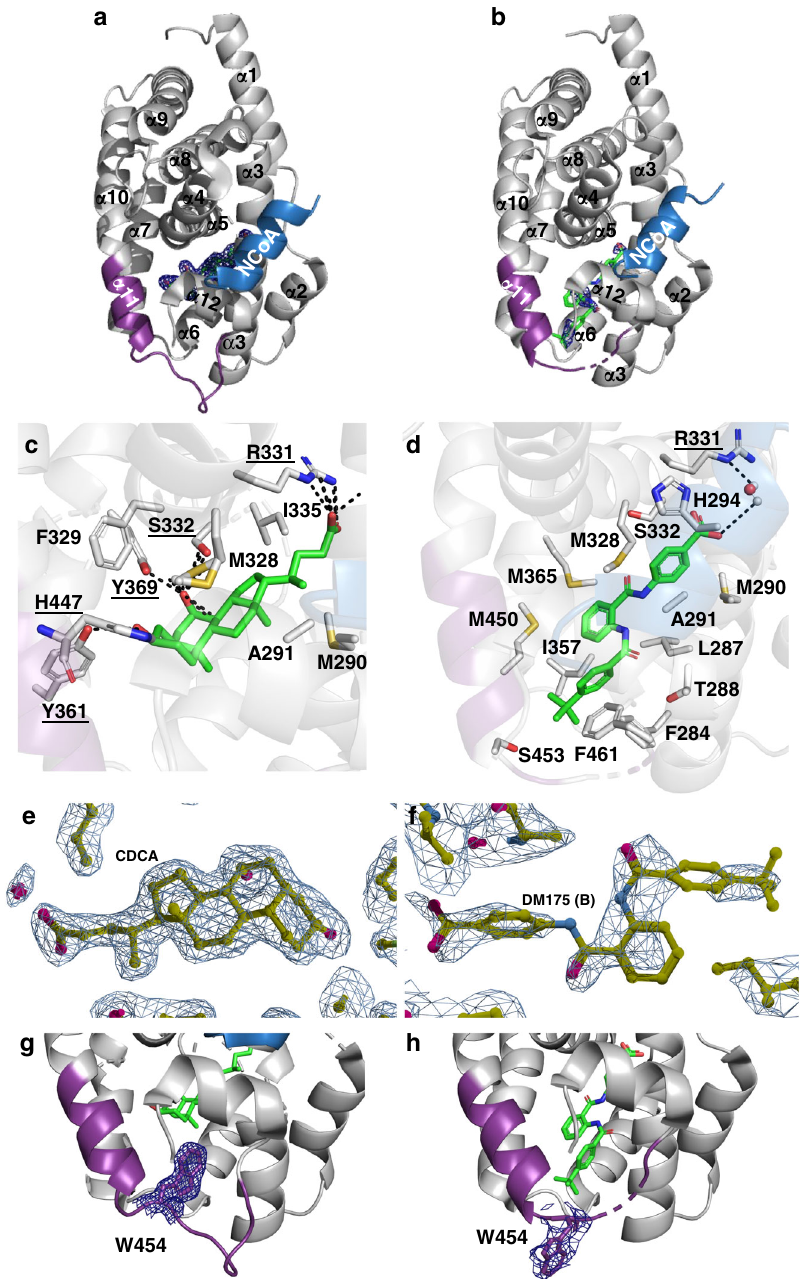
Fig. 2 Binding modes of physiological FXR agonist CDCA and partial agonist 1 to the FXR-LBD. a CDCA bound to FXR. The co-activator (NCoA) is highlighted in blue. b Compound 1 bound to FXR. c , d Key residues involved in the interaction with CDCA and compound 1 , respectively. e , f 2Fc-Fo omit maps (contour level 1.0 σ ) for CDCA and compound 1 (chain B), respectively bound to the FXR-LBD. Chain B was considered for all interpretation due to preferable electron density for the ligand. Ligand density for chain A is poor due to twinning of the crystal. Additionally, the electron density of the loop region connecting α 11 and α 12 (V456-H459, AF-2 loop) in chain B is ambiguous or invisible, due to induced fl exibility by binding of 1 . g , h Compared to CDCA-bound FXR, binding of the partial agonist 1 causes an outward movement of W454 by 12 Å (2Fc-Fo omit maps, contour level 1.0 σ